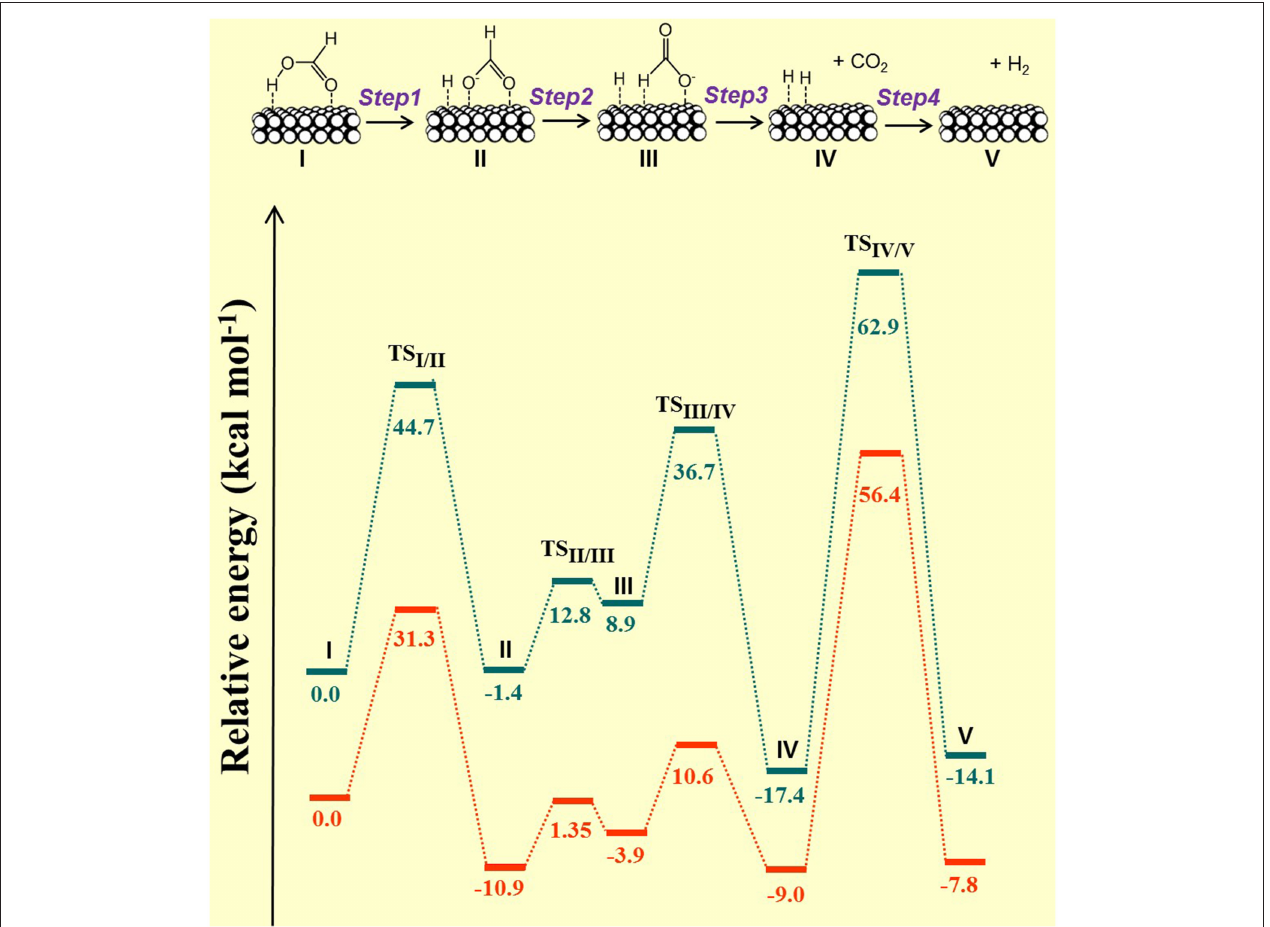
FIGURE 11 | Reaction pathway and profiles of potential energy for the formic acid dehydrogenation reaction catalyzed by Pd monometallic (Pd 43, in blue) and bimetallic (Pd 22 Co 21, in orange) clusters. Adapted with permission from Navlani-García et al. (2018b). Copyright 2018 Elsevier.